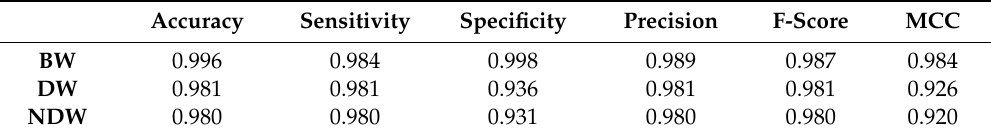
Table 5. Performance metrics